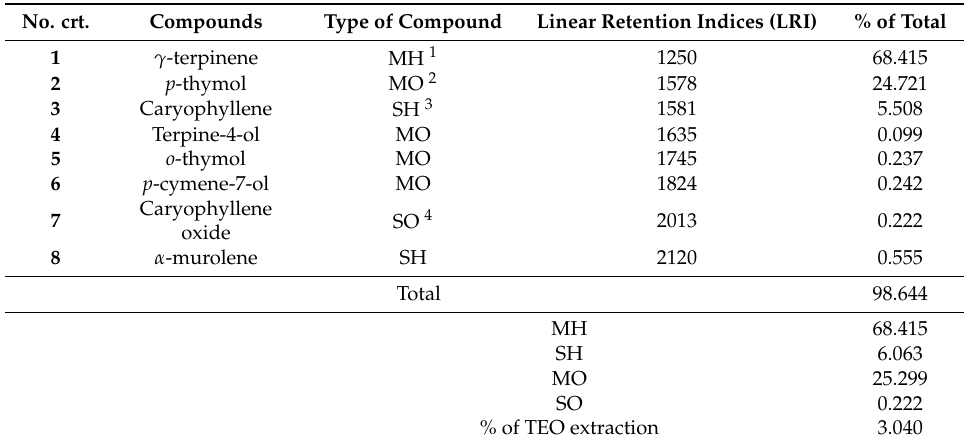
Table 2. Chemical composition of Thymus vulgaris essential oils